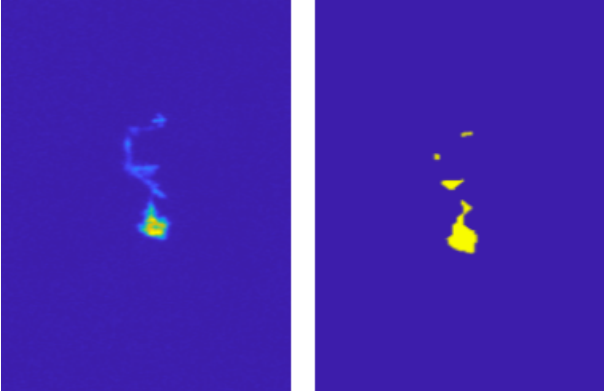
Figure B2. A precipitation particle split into fragments that could be confused with blowing snow particles. The cumulative distance trans- form descriptor is much less affected by such image-processing issues than the number of